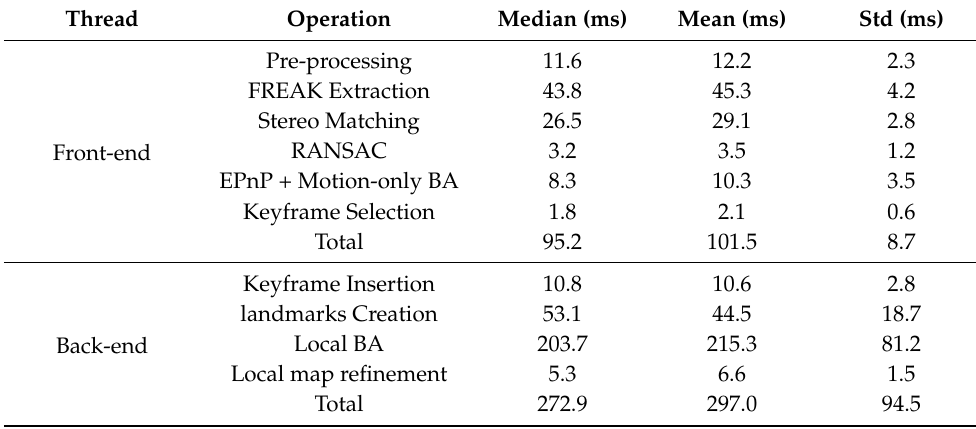
Table 3. Timing of main components of our